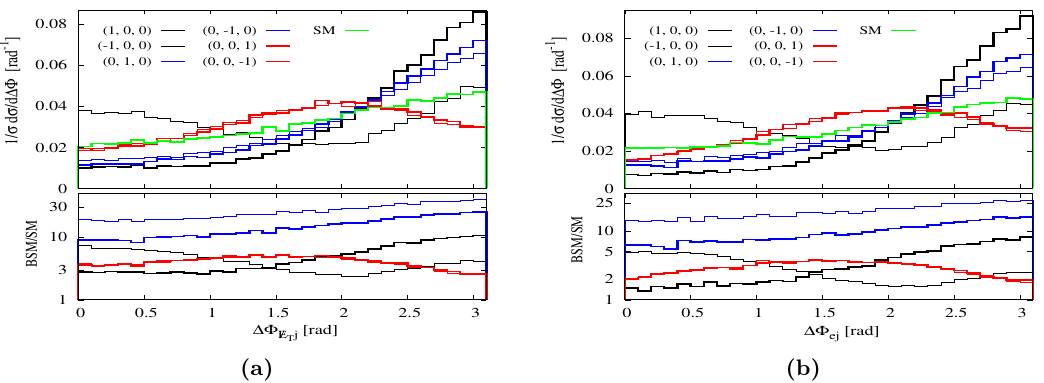
Figure 4 . BSM effects in azimuthal angle distributions for CC (left) and NC (right) processes. The numerical values in the brackets refer to the values of BSM parameters ( λ 1 V , λ 2 V , ˜ λ V ). The lower panel in each plot gives the ratio of BSM and SM